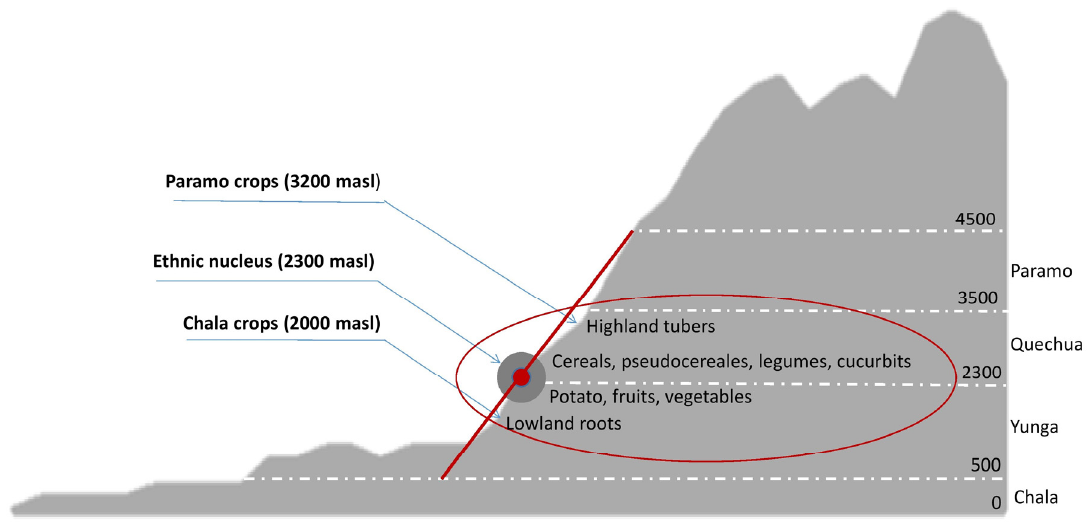
Figure 11. Agroecological diversification model of the Chanchán basin.